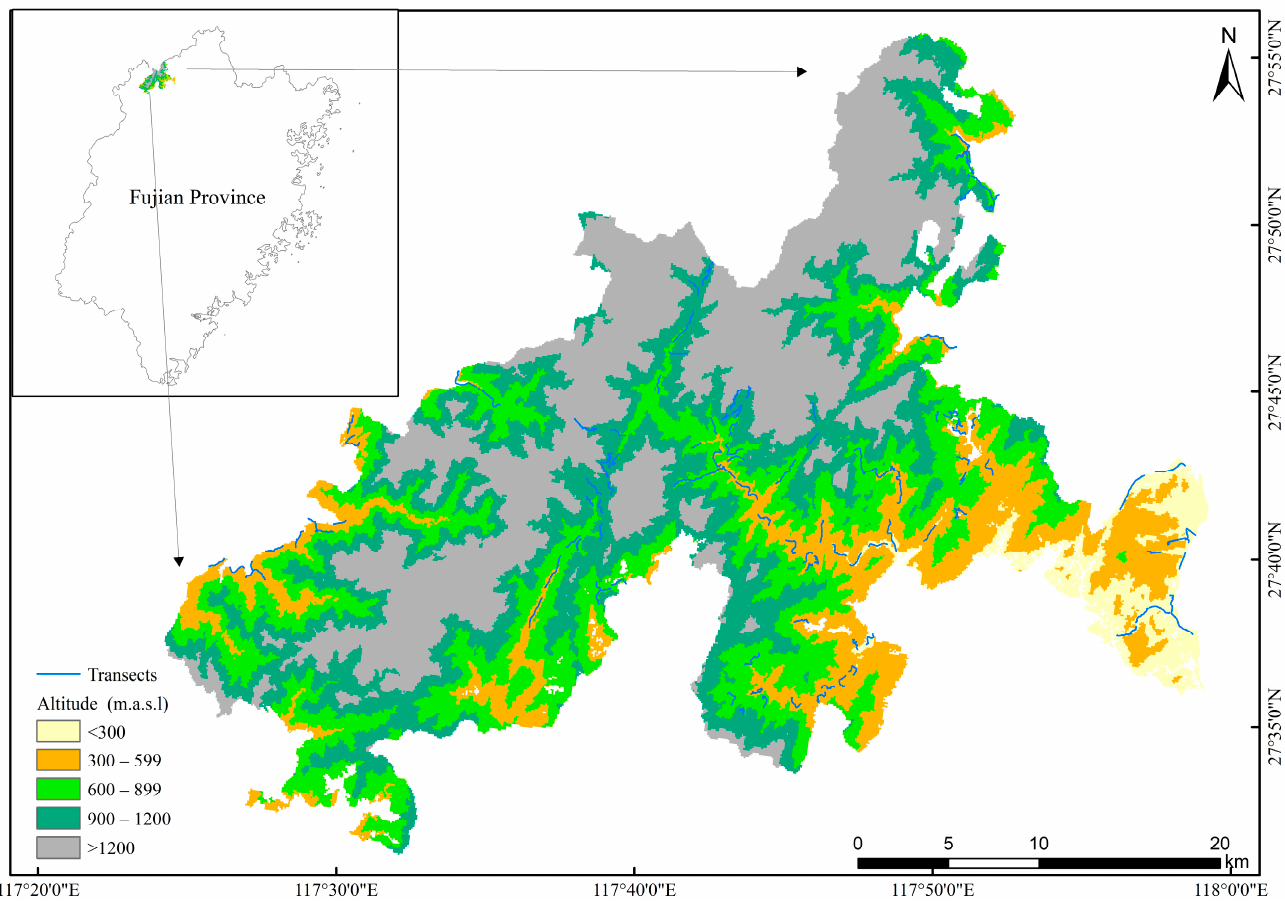
Figure 1. The location of transects in Wuyishan National Park. The coordinate system is